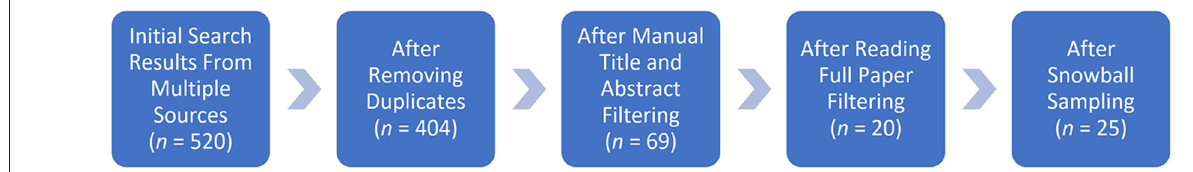
FIGURE 1 | Number of papers included in review after various stages of filtering.